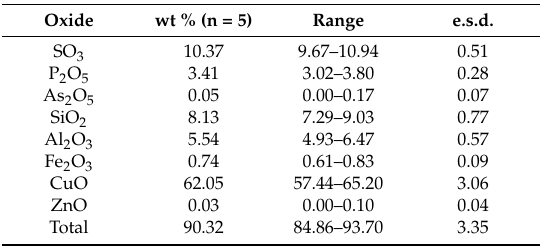
Table 1. Chemical data of